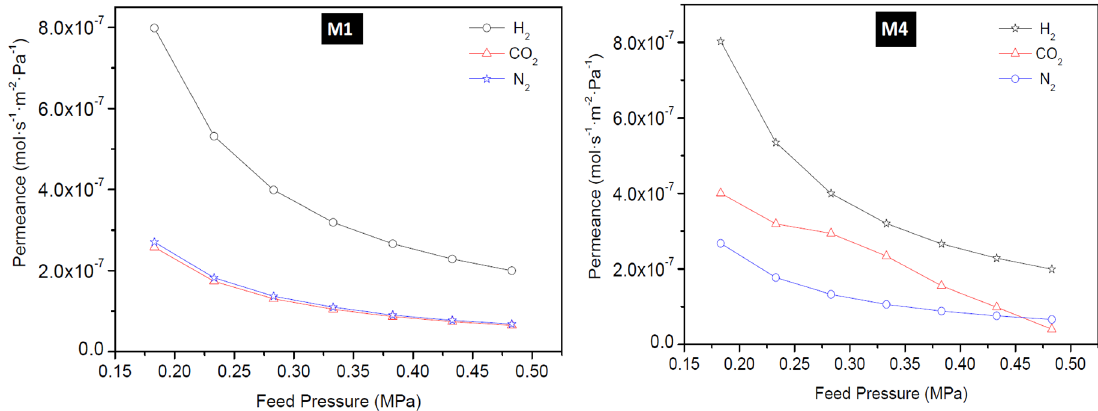
Figure 10. H 2 permeance, CO 2 permeance, and N 2 permeance as a function of feed pressure at 25 °C for membrane B1 and B2 prepared using the direct hydrothermal method.